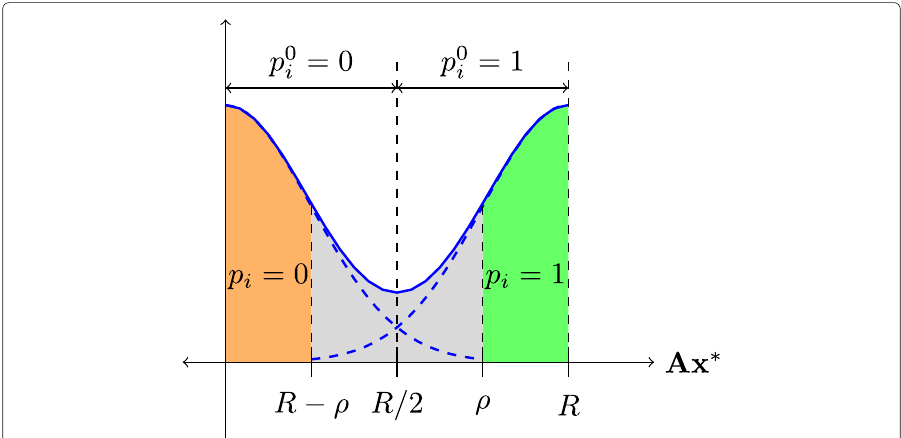
Fig. 3 Analysis of the density plot ofmod ( Ax ∗ ) . Best viewed in color. Notice that the area of green and orange regions indicate the number of measurements for which the bin-indices are identified correctly using Eq.